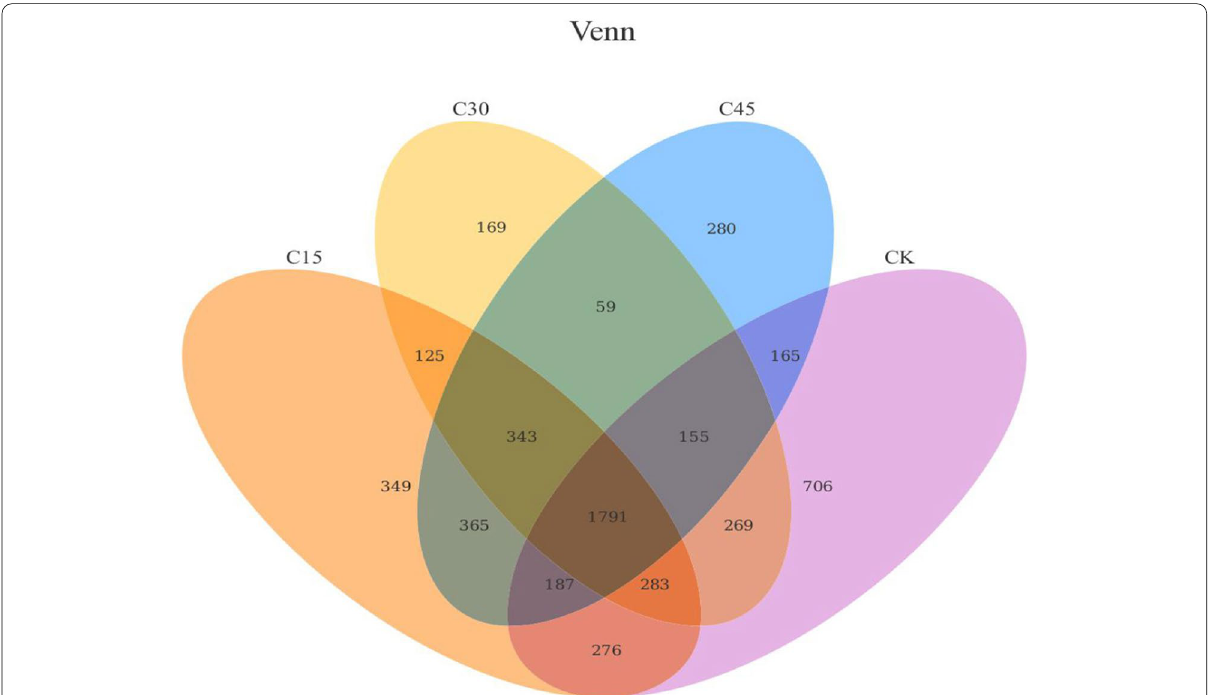
Fig. 4 Venn diagram of soil microbial OTU numbers at different oil pollution concentrations